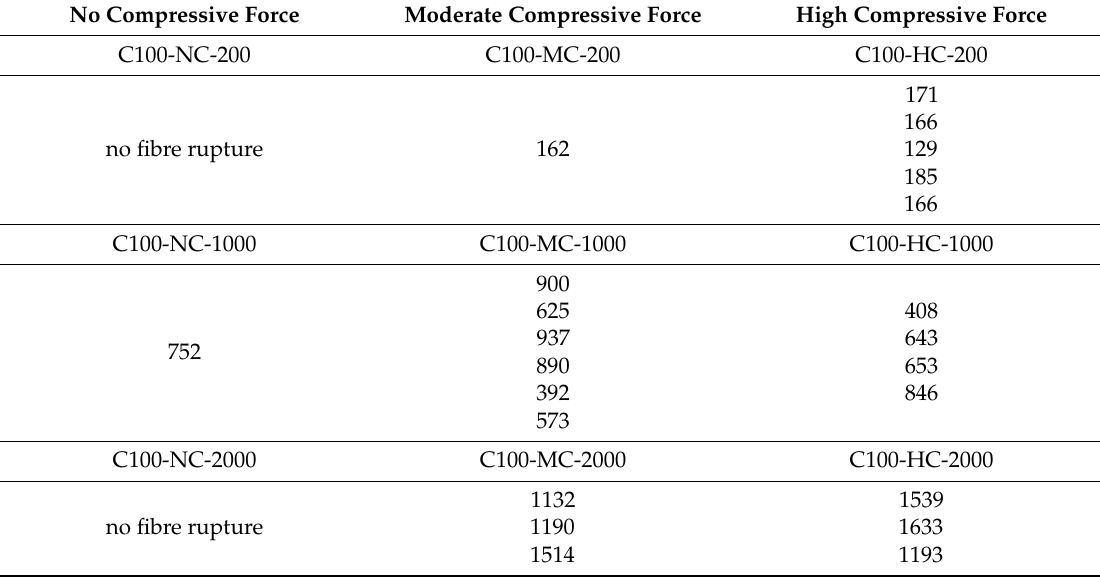
Figure 9. Frequency of fibre rupture during the cyclic stage depending on the number of cycles and compressive force on the fracture section. Table 5. Number of cycles before fibre rupture for the specimens with large crack